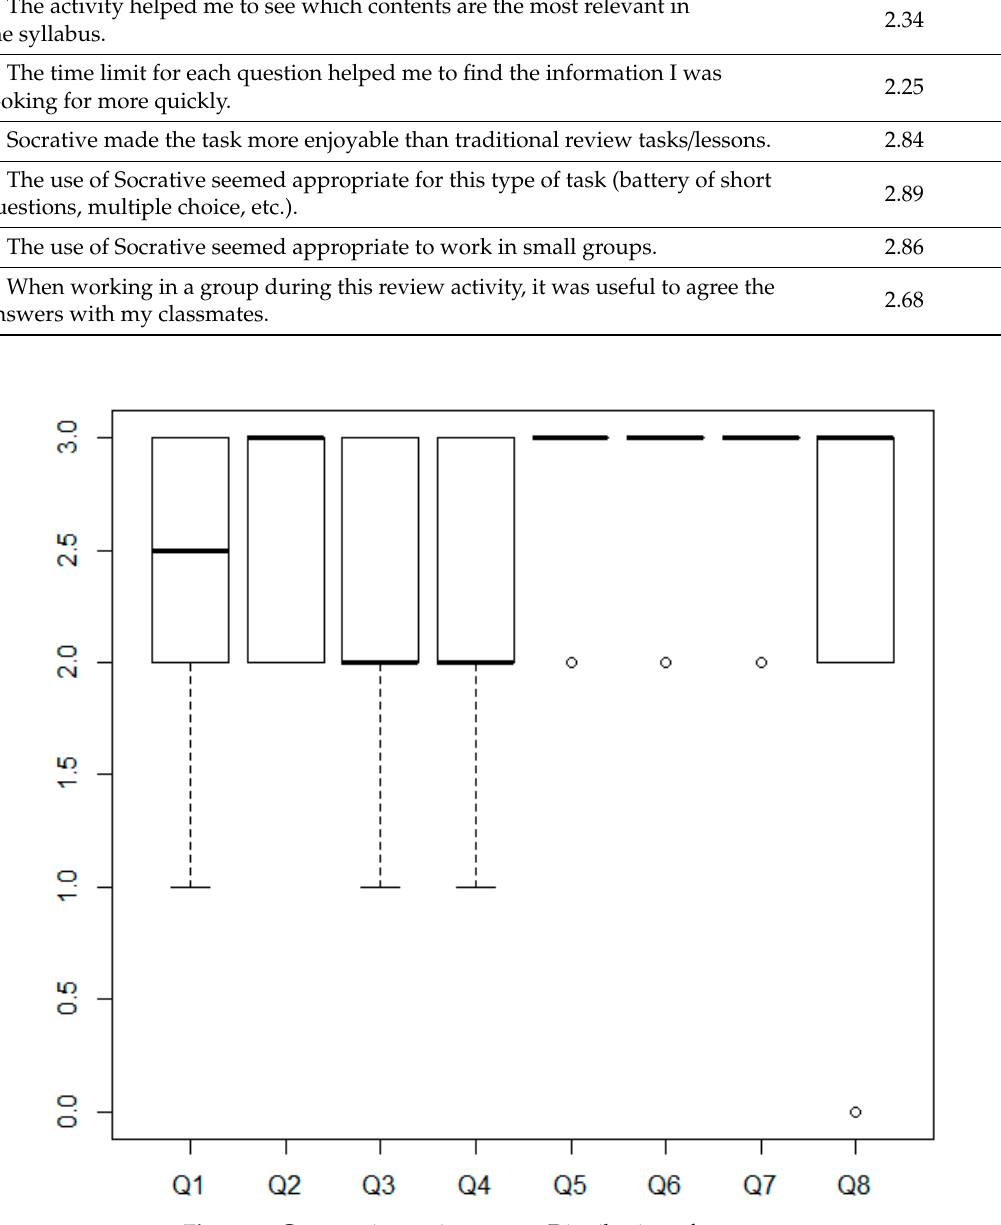
Figure 3. Cooperative review game: Distribution of responses.